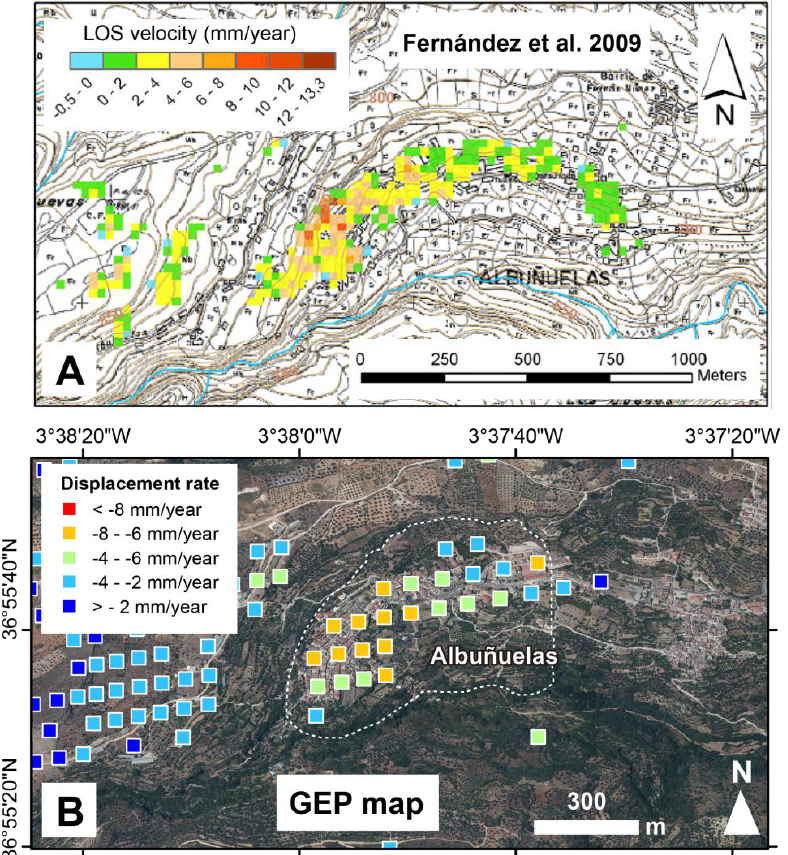
Figure 5. Comparison between the displacement rates measured by Fernandez et al. [30] ( A ) and the GEP map ( B ) in the Albuñuelas village. The boundary of the active landslide is indicated by white dotted lines.